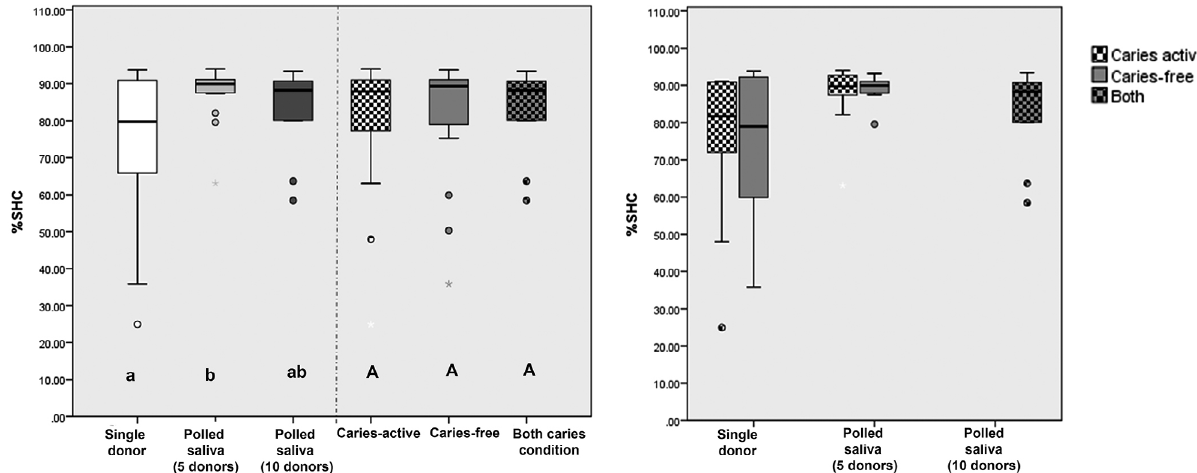
Figure 2- %SHC and (SD) values considering inoculum and caries activity levels (right side) and statistical set-up (left side). Upper case letters show statistical difference between caries activity level (caries free, caries active or both). Lower case letters show statistical difference among inoculum level (single donor, pooled saliva from 5 donors and 10 donors). The circles represent outliers and the asterisks extreme